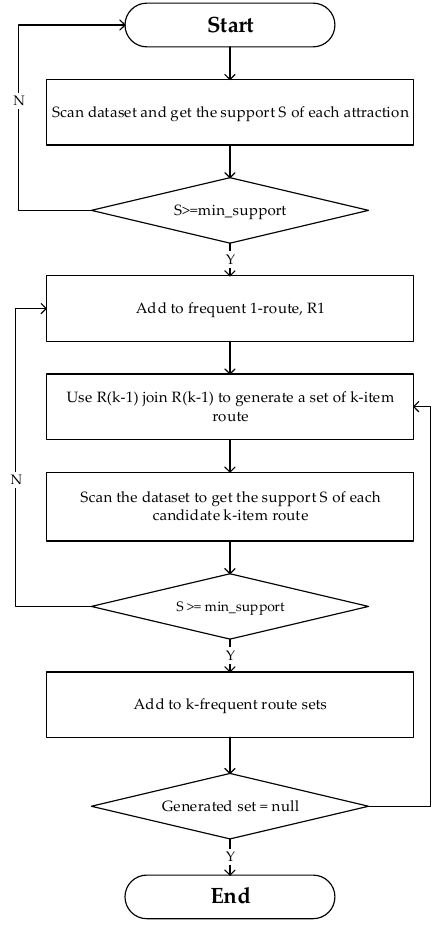
Figure 4. Flowchart of frequent route set generation.